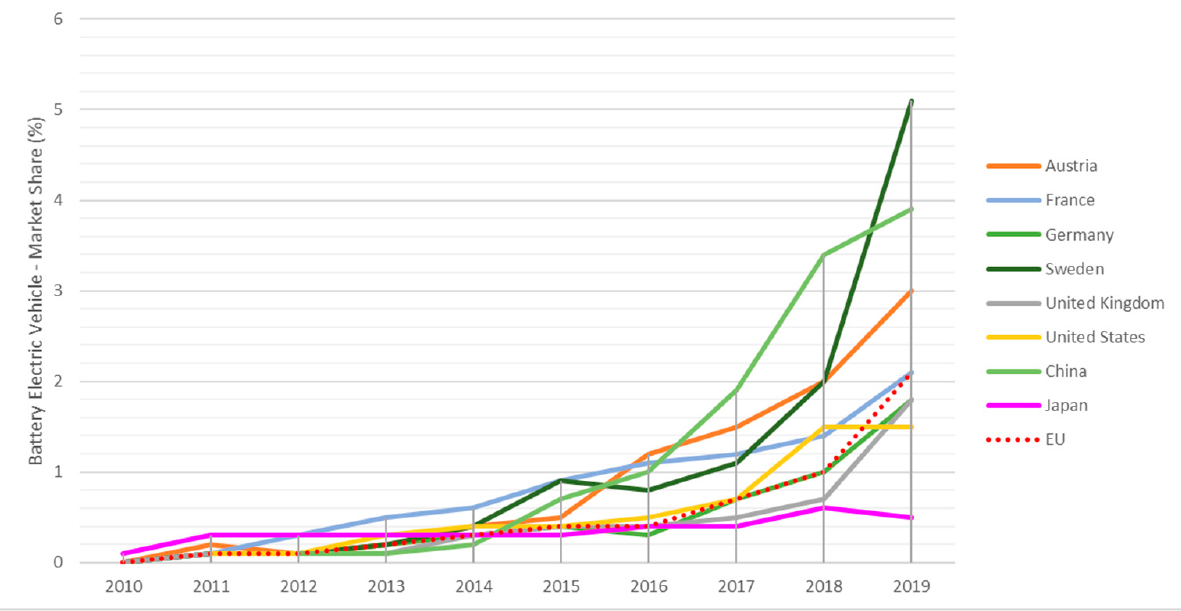
Figure 5. Battery electric vehicle market share in new registrations in major countries with a mar- ket share below 6% [36,37].